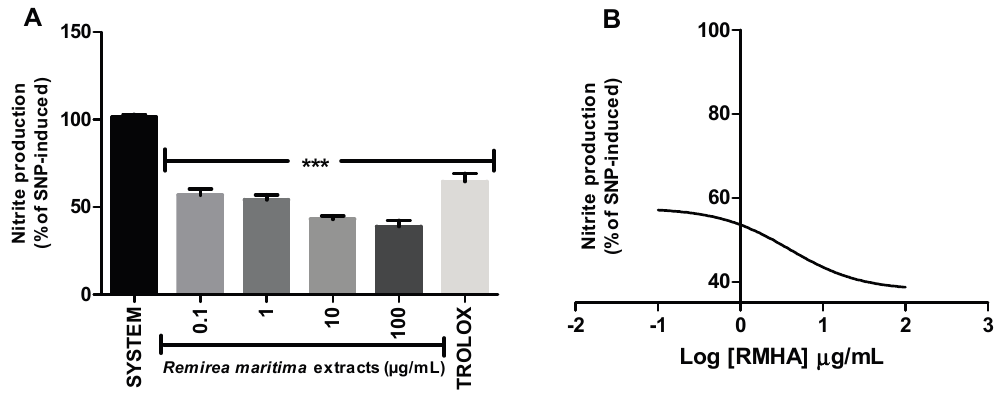
Figure 5. Nitric oxide (NO) scavenging assay ( A ) NO was generated from spontaneous decomposition of sodium nitroprusside (SNP) in the presence O 2 , producing NO 2 ‒ ions which were measured by the Griess reaction. Trolox ® (75 µg/mL) was used as standard antioxidant; ( B ) Log IC 50 of RMHA NO scavenging activity. Bars represent mean ± SEM. *** p < 0.001 (1-way ANOVA followed by Tukey’s multiple comparison post hoc